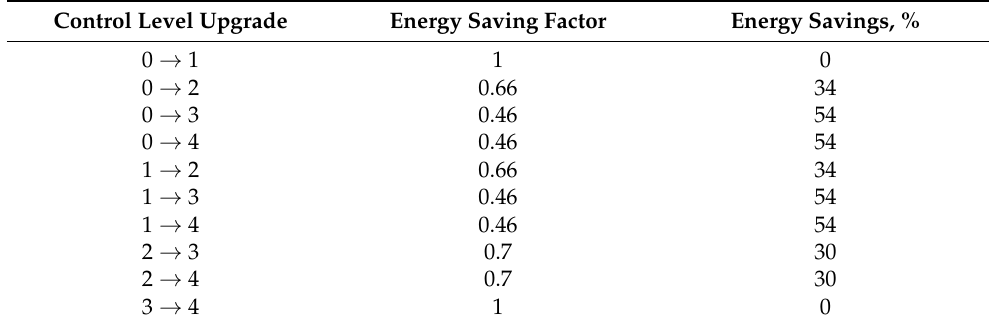
Table 1. Variations of the emission control service level of control upgrades, calculated energy saving factors and normalized energy savings. Control Level Upgrade Energy Saving Factor Energy Savings,